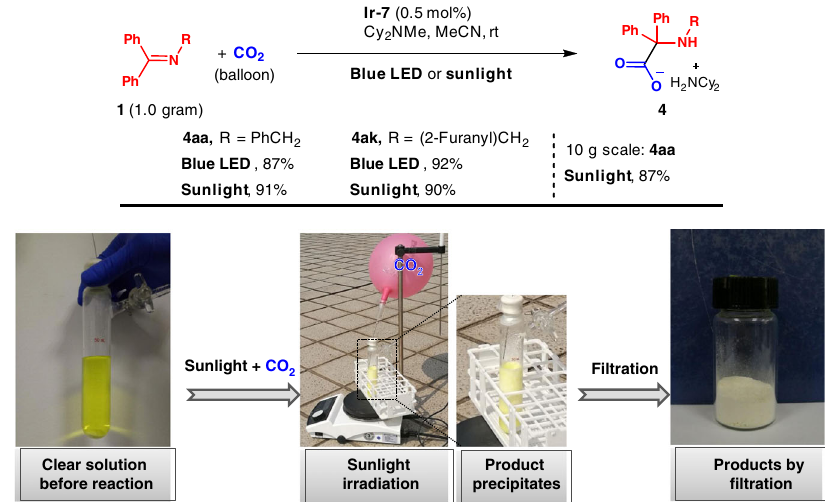
Fig. 4 Upscaling experiments. Gram-scale preparation of α -amino acids via fi xation of CO 2 promoted by visible light or sunlight